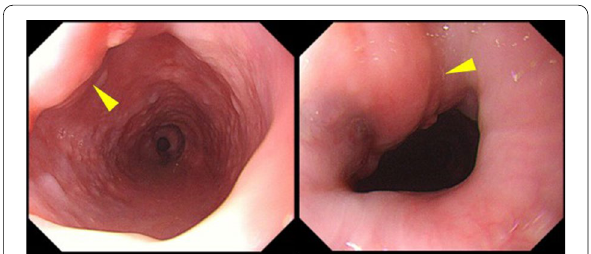
Fig. 1 Preoperative upper gastrointestinal endoscopy. An elevated lesion was revealed on the anterior wall of the upper thoracic esophagus (arrowhead). This confirmed compression from something external